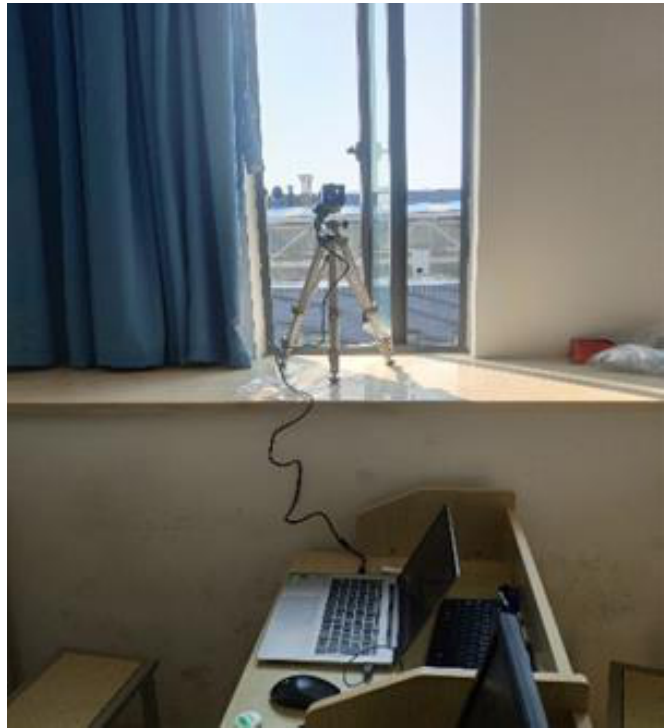
Figure 5. UV detection equipment for plume